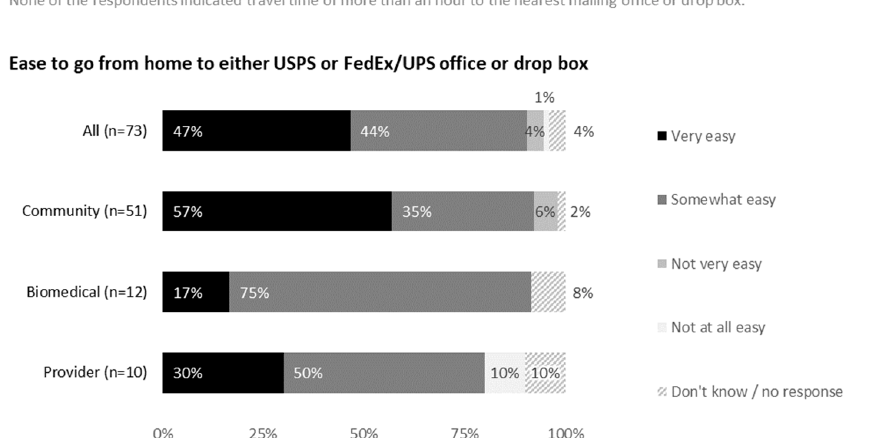
Figure 3. Feedback on mailing blood samples to a laboratory or research site from all participants (United States, 2021).